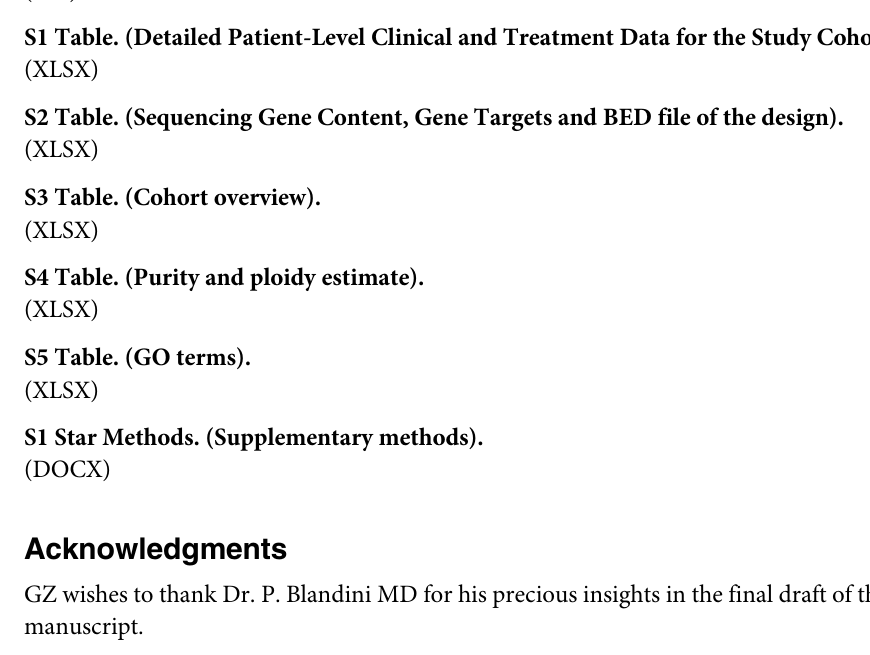
S1 Table. (Detailed Patient-Level Clinical and Treatment Data for the Study Cohort). S2 Table. (Sequencing Gene Content, Gene Targets and BED file of the design). S3 Table. (Cohort overview). S4 Table. (Purity and ploidy estimate). S5 Table. (GO